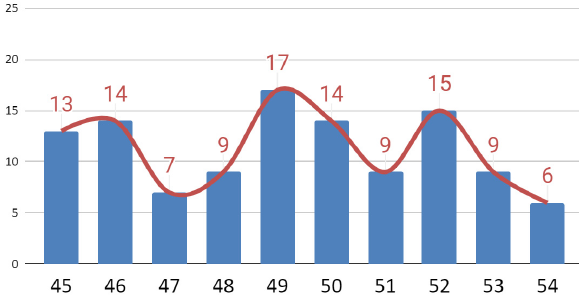
Figure 10. Distribution of patients depending on the amplitude of mouth opening.